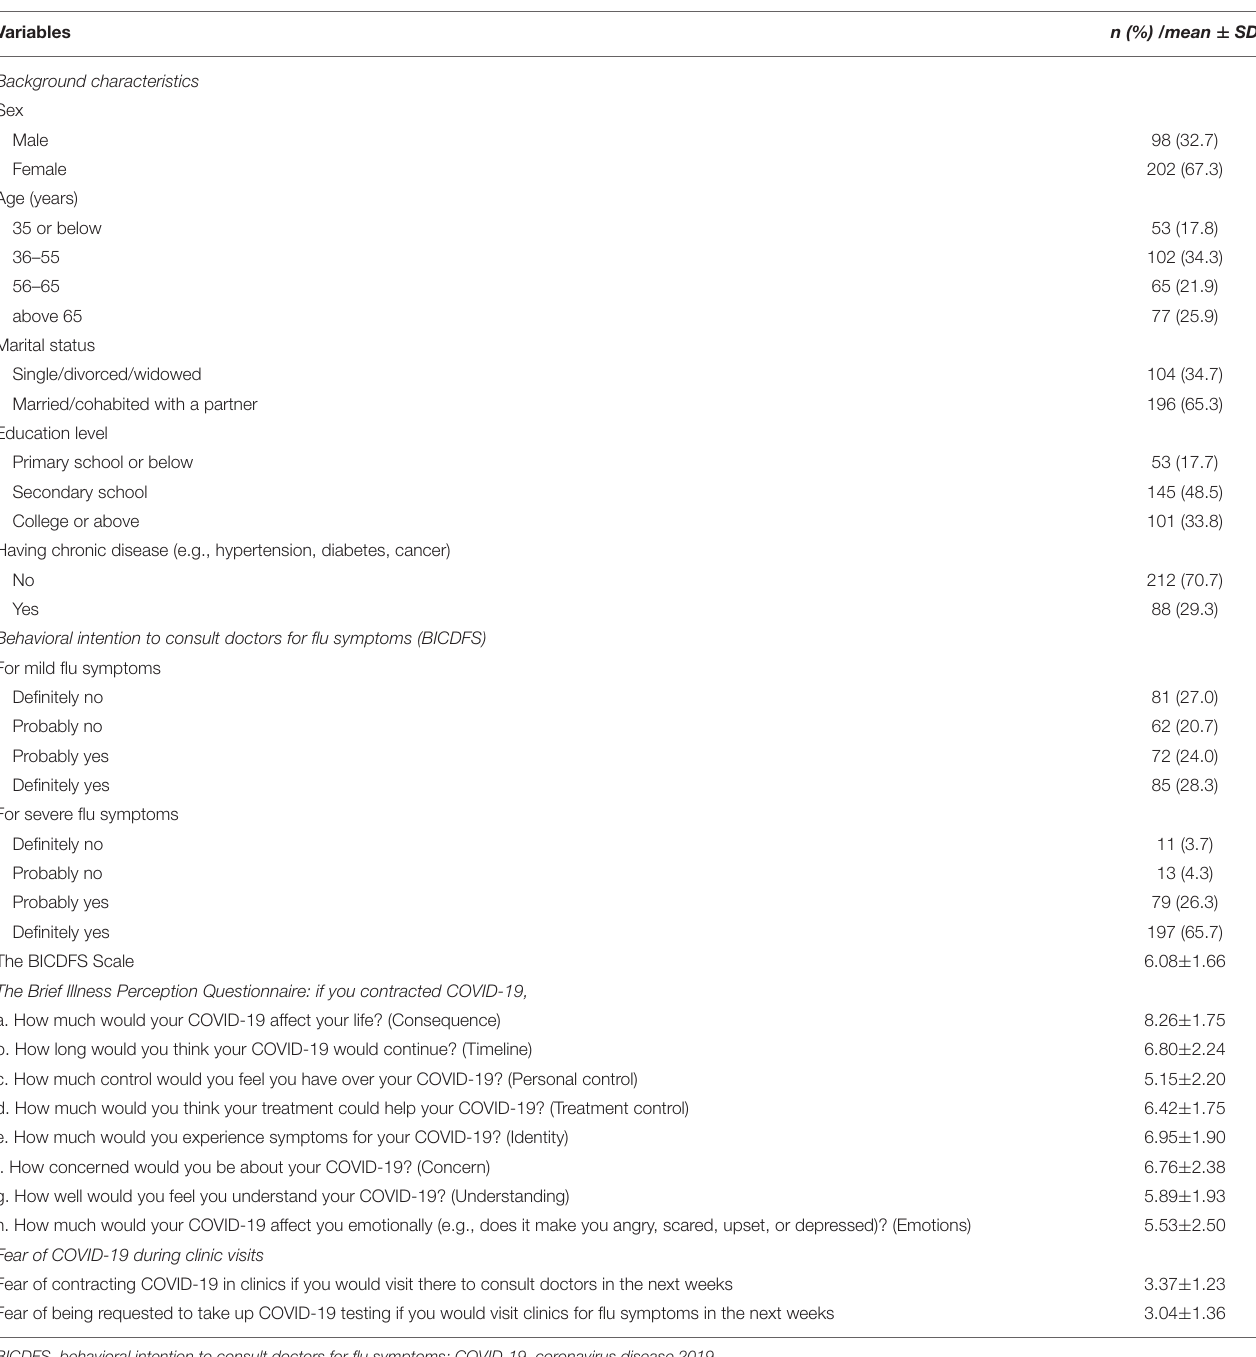
TABLE 1 | Distributions of the studied variables ( N =